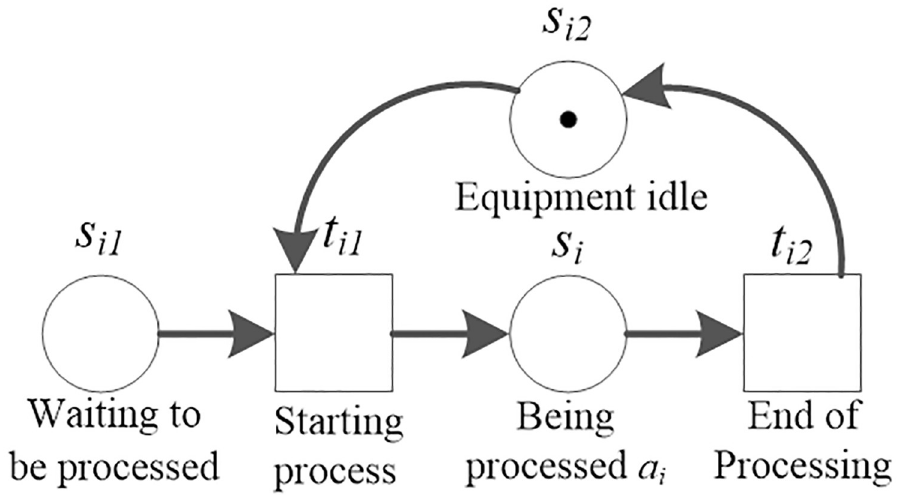
Fig 5. Petri net model of one